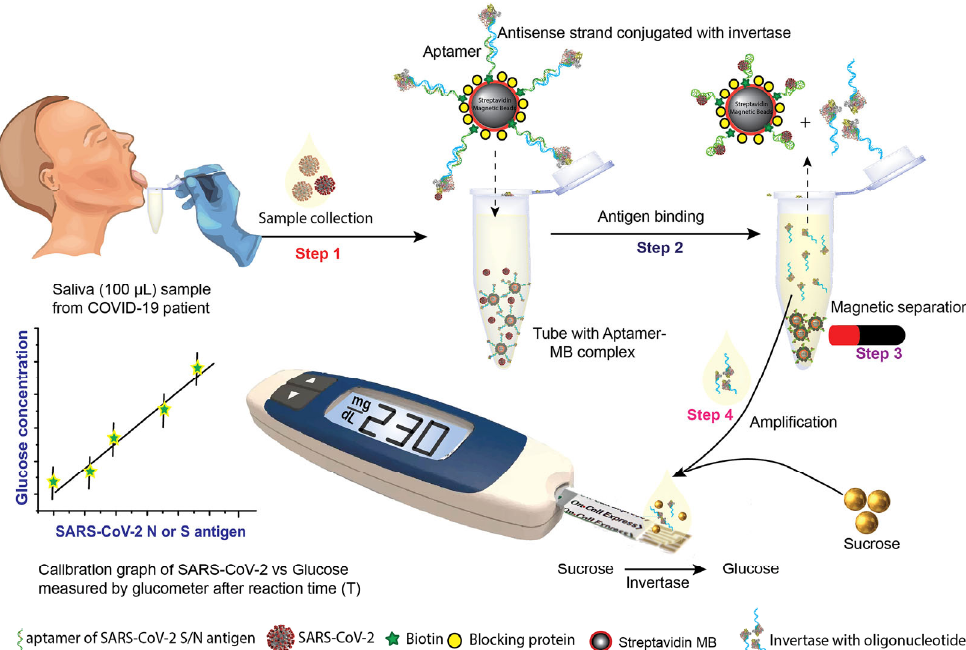
Figure 12. Overview of proposed POC, SARS ‐ CoV ‐ 2 N, or S protein ‐ specific biotinylated aptamer ‐ based COVID ‐ 19 assay. In the first step, saliva is added to this cocktail. In the second step, the viral antigen or the SARS ‐ CoV ‐ 2 virion binding is released. In the third step, the magnetic separation of magnetic nanoparticles conjugated to the aptamer ‐ antigen complex is used. In the final step, the remaining solution is collected and incubated with sucrose. Invertase, which is contained in the solution, converts sucrose to glucose which can be directly measured using a portable glucometer. The glucose concentration is correlated with the SARS ‐ CoV ‐ 2 N or S protein concentration (reprinted with permission from [136]).